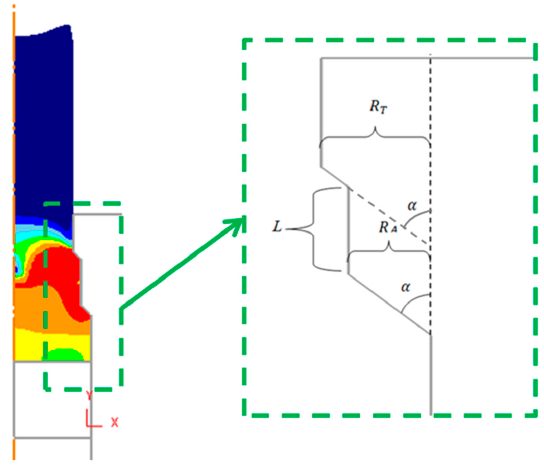
Figure 3. Geometrical definition of double-pass die.